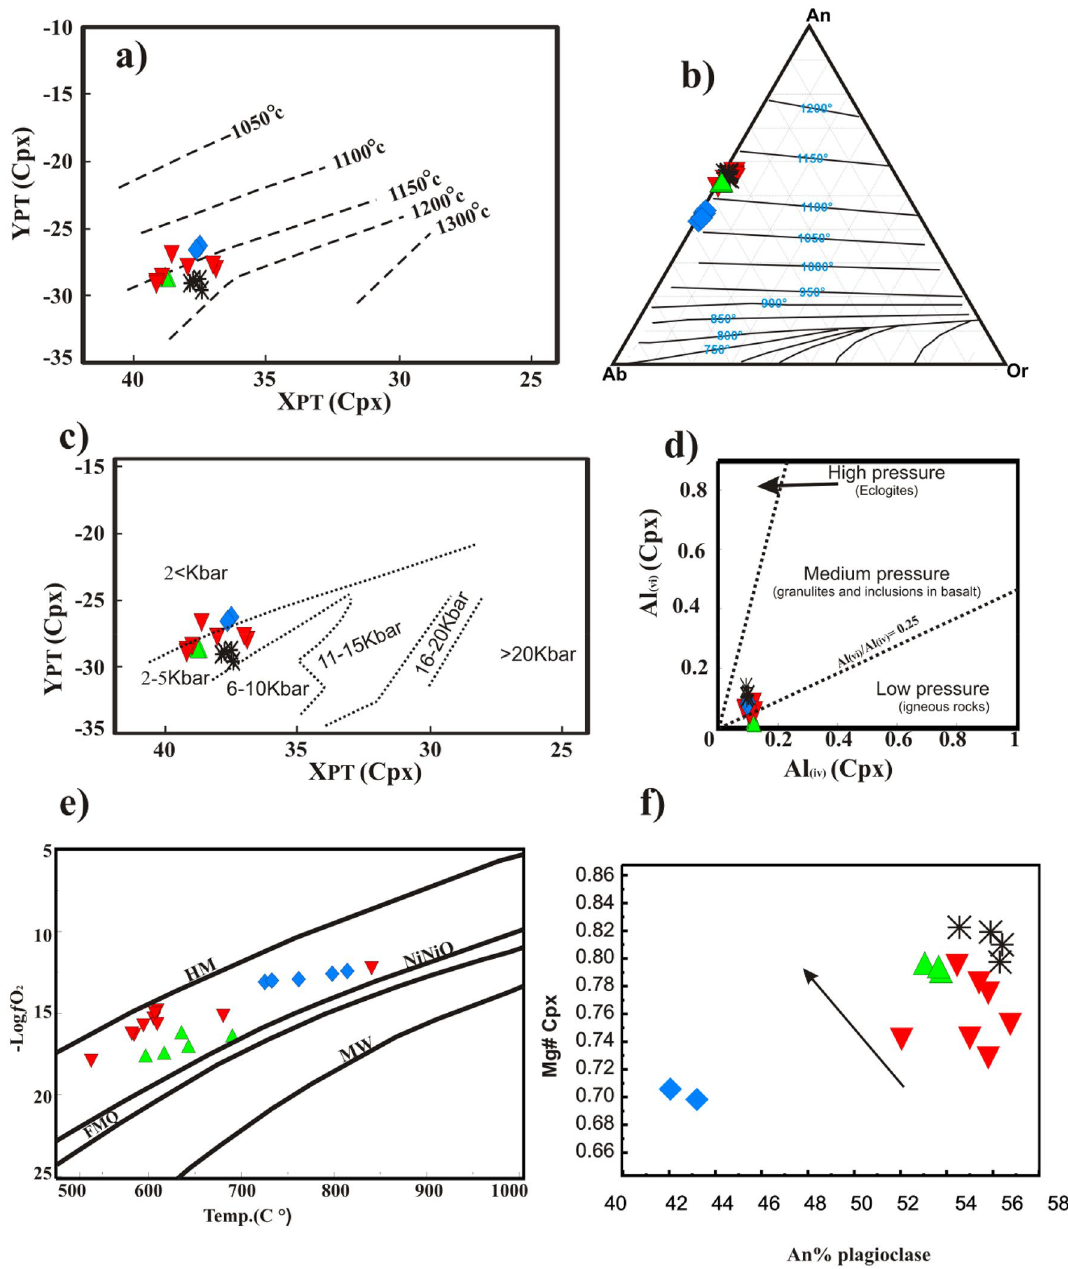
Figure 11. ( a ) XPT versus YPT diagram 31 for the determination of the pyroxene crystallization temperature "XPT = 0.446SiO 2 ‏ + 0.l87TiO 2 − 0.404A1 2 O 3 ‏ + 0.346FeO t − 0.052MnO + ‏ 0.309MgO + ‏ 0.431CaO − 0.446Na 2 O, YPT = − 0:369SiO AlVI vs. AlIV (Cpx) barometry diagram 35 , ( e ) temperature versus oxygen (ƒO2) fugacity diagram, and ( f ) An % plagioclase versus Mg# of clinopyroxene in the studied intrusion